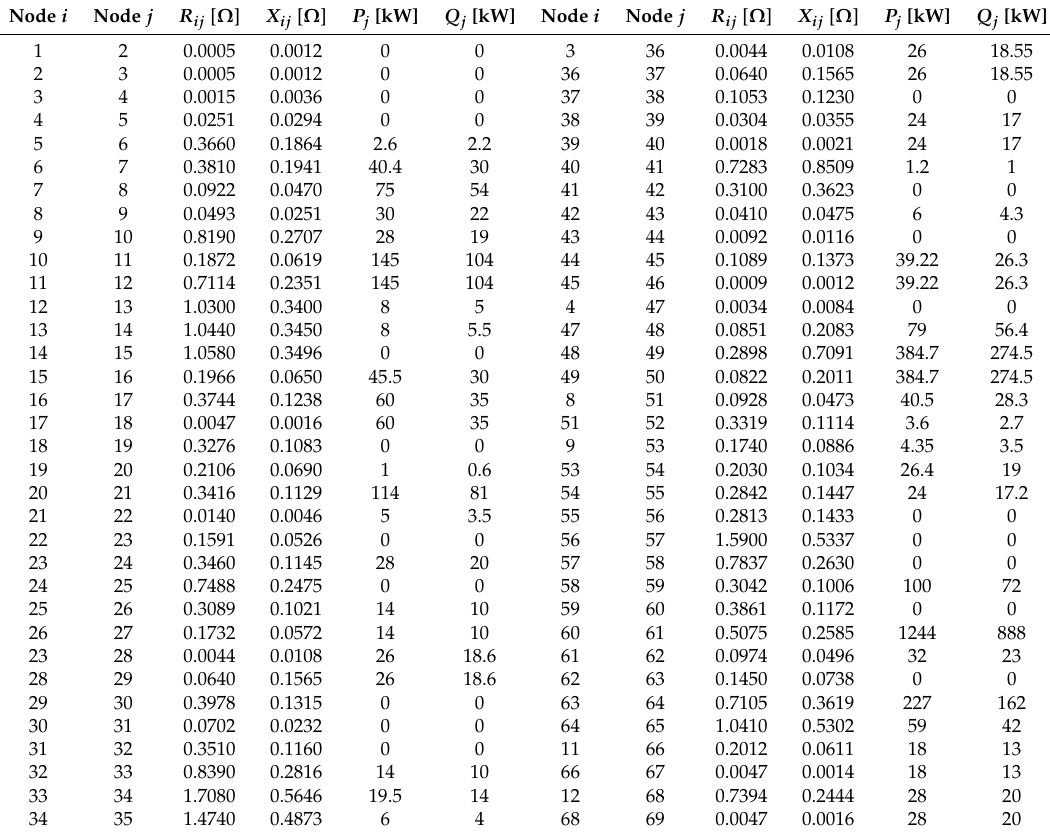
Table 4. Electrical parameters of the 69-node test